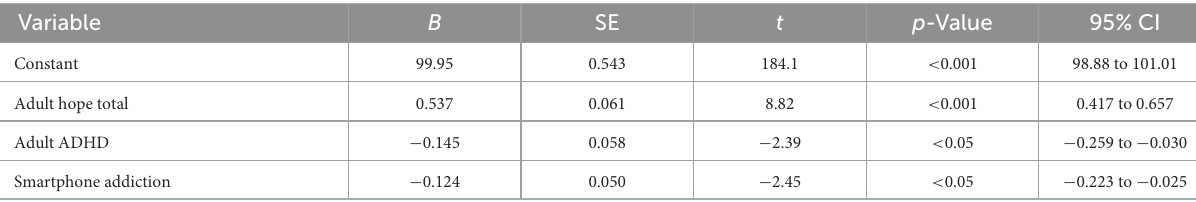
TABLE 4 Regression coefficients of hope, adult ADHD and smartphone addiction on